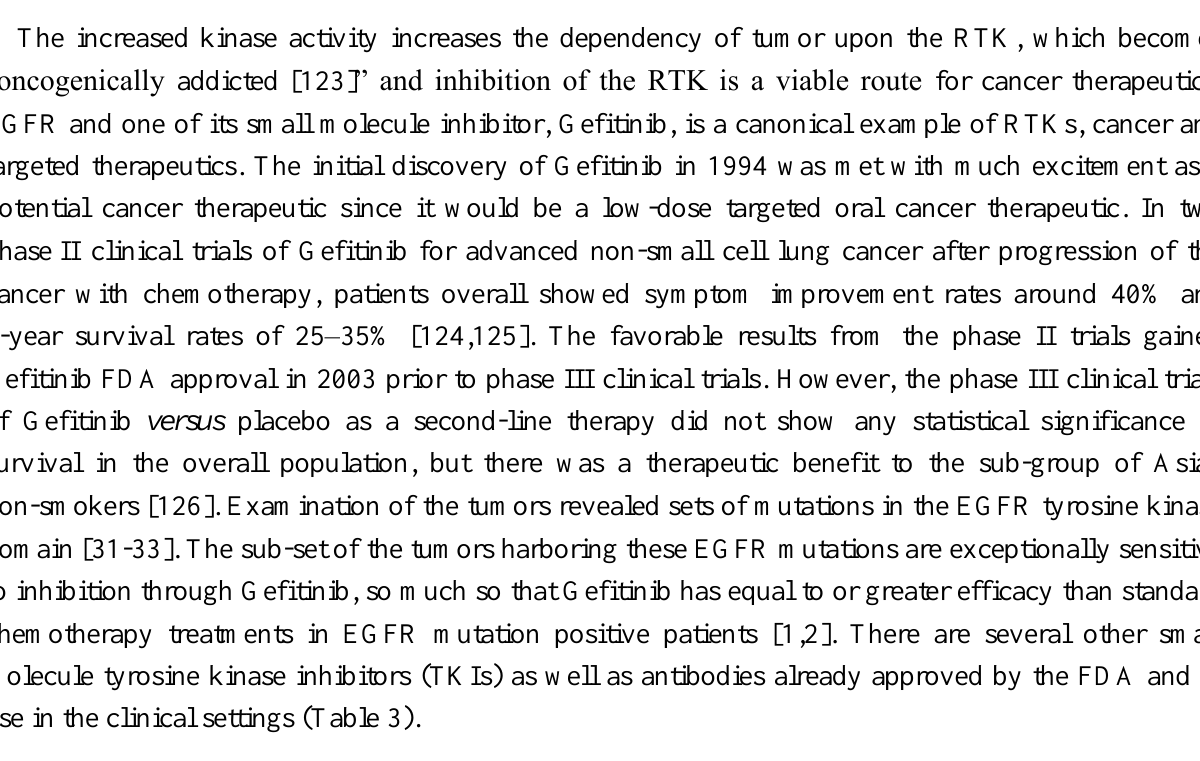
Table 3. FDA approved RTK inhibitors and antibodies currently in